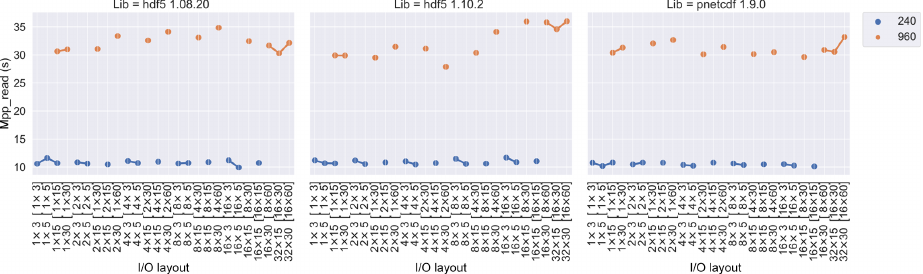
Figure 4. mpp_read time (in seconds) versus I / O layout in different libraries and PE numbers. Read operations do not use I / O layout or parallel I / O, and runtimes are largely independent of layout and library. Read times increase significantly as the number of PEs is increased. The I / O layout together with its PE distribution in [PE per node × nodes] are labelled on the x axis.